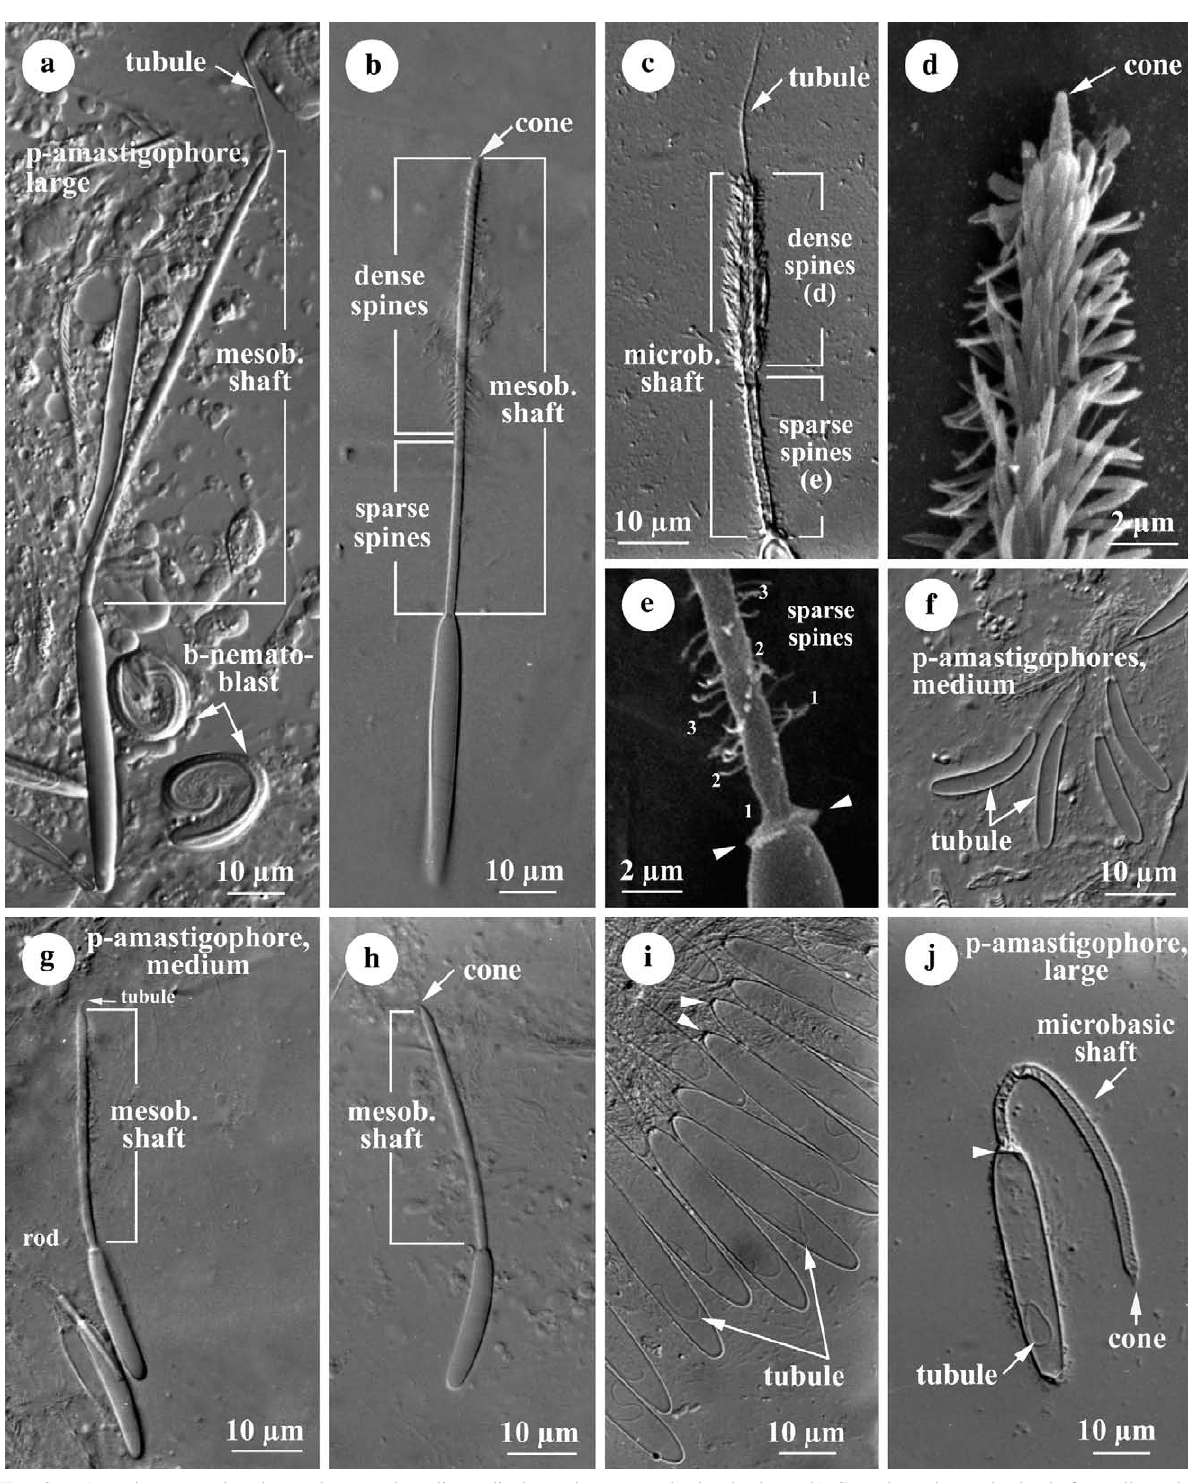
Fig . 2. – Acontia p-amastigophores, large and medium; discharged meso- and microbasics. a,b) Capsule and mesobasic shaft swollen with fluid. a) Shows tiny tubule at shaft end. Also two b-mastigophore nematoblasts with shaft- and tubule-coils inside folded capsule. b) Note dense spines on main shaft and sparse spines on proximal shaft. c) Microbasic shaft with tiny tubule and dense spines on main shaft. d) Distal main shaft with dense spines (upper region d in Figure c) and conical tip (SEM). e) Sparse spines on proximal shaft (lower region e in Figure c). Note flaps at capsule apex (arrow heads) (SEM). f) Microbasic p-amastigophores, medium, with tiny tubules inside discharged capsules. g,h) Mesobasic p-amastigophores, medium. g) Shaft with tiny tubule. Note rod at end of partly discharged shaft (lower left). h) Shaft with conical tip. i,j) Microbasic p-amastigophores, large. i) Discharged capsules, each with a tiny tubule inside. j) Conspicuous tubule in capsule (freeze-dried preparation). Arrow heads point at flaps at capsule apex; b-nematoblast, nematoblast of b-mastigophores; mesob ., mesobasic; microb. , microbasic; 1,2,3, three